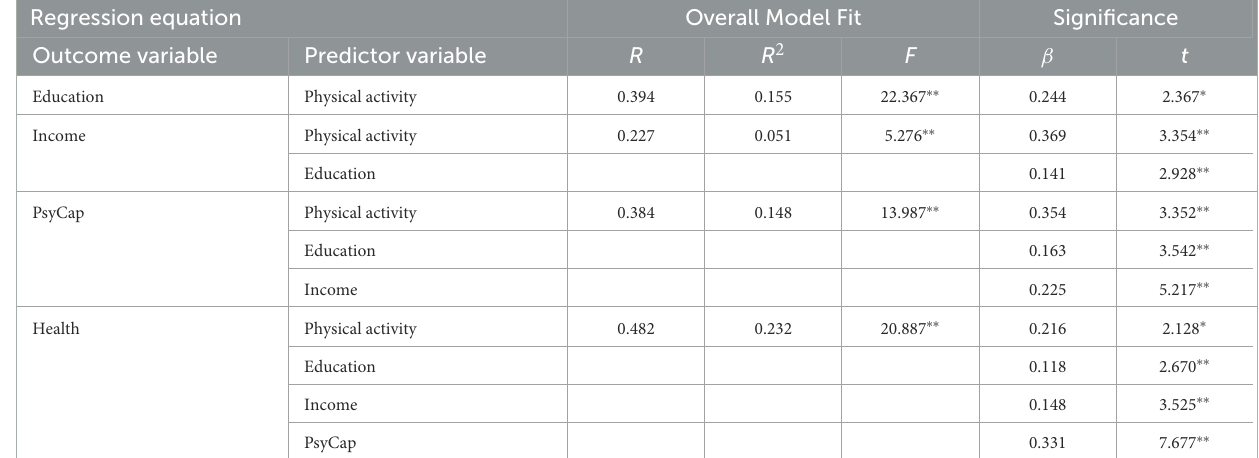
TABLE 2 Regression analysis among